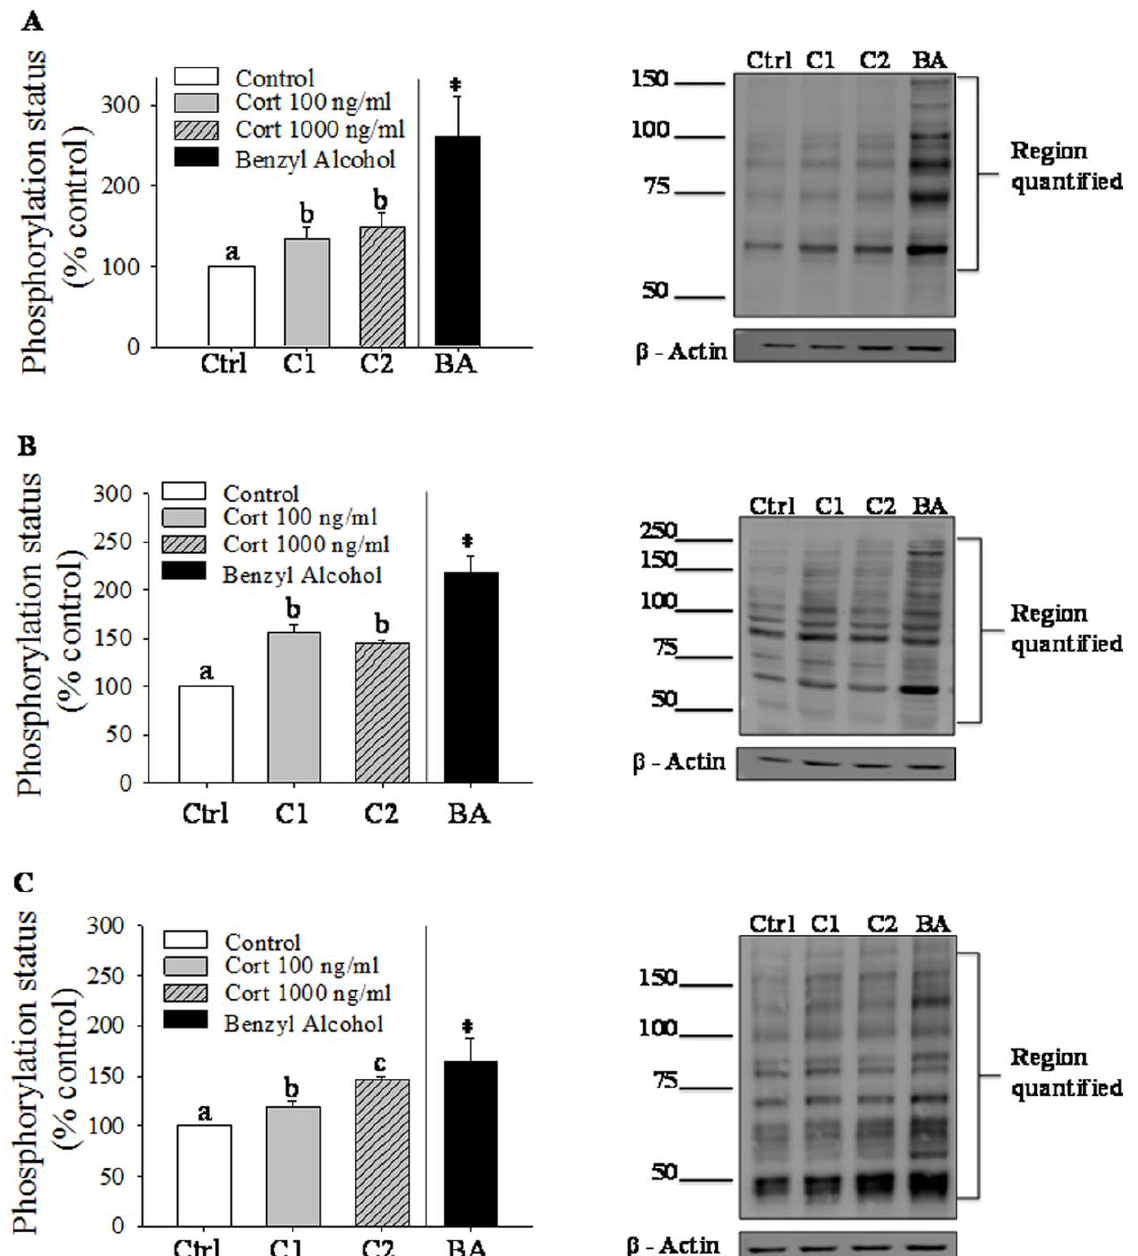
Figure 3. Cortisol effect on rapid cell signaling in trout hepatocytes. Rainbow trout hepatocytes were incubated either with cortisol (0, 100 or 1000 ng/mL) or benzyl alcohol (BA; 25 mM) for 10 min. Cell homogenates (40 m g protein) were probed with polyclonal rabbit antibody (Cell Signaling Technology, Beverly, MA) to either phospho-(Ser) PKC substrate (A), phospho-PKA Substrate (RRXS/T) (B) or phospho-Akt substrate (RXXS/T) (C). Equal loading was confirmed with b -actin (monoclonal mouse antibody; Sigma, St. Louis, MO). A representative immunoblot for each is shown; values are plotted as % control and shown as mean 6 S.E.M (n=3 independent fish); bars with different letters are significantly different (repeated measures ANOVA, p , 0.05). *significantly different from control (Paired Student’s t-test; p , 0.05).